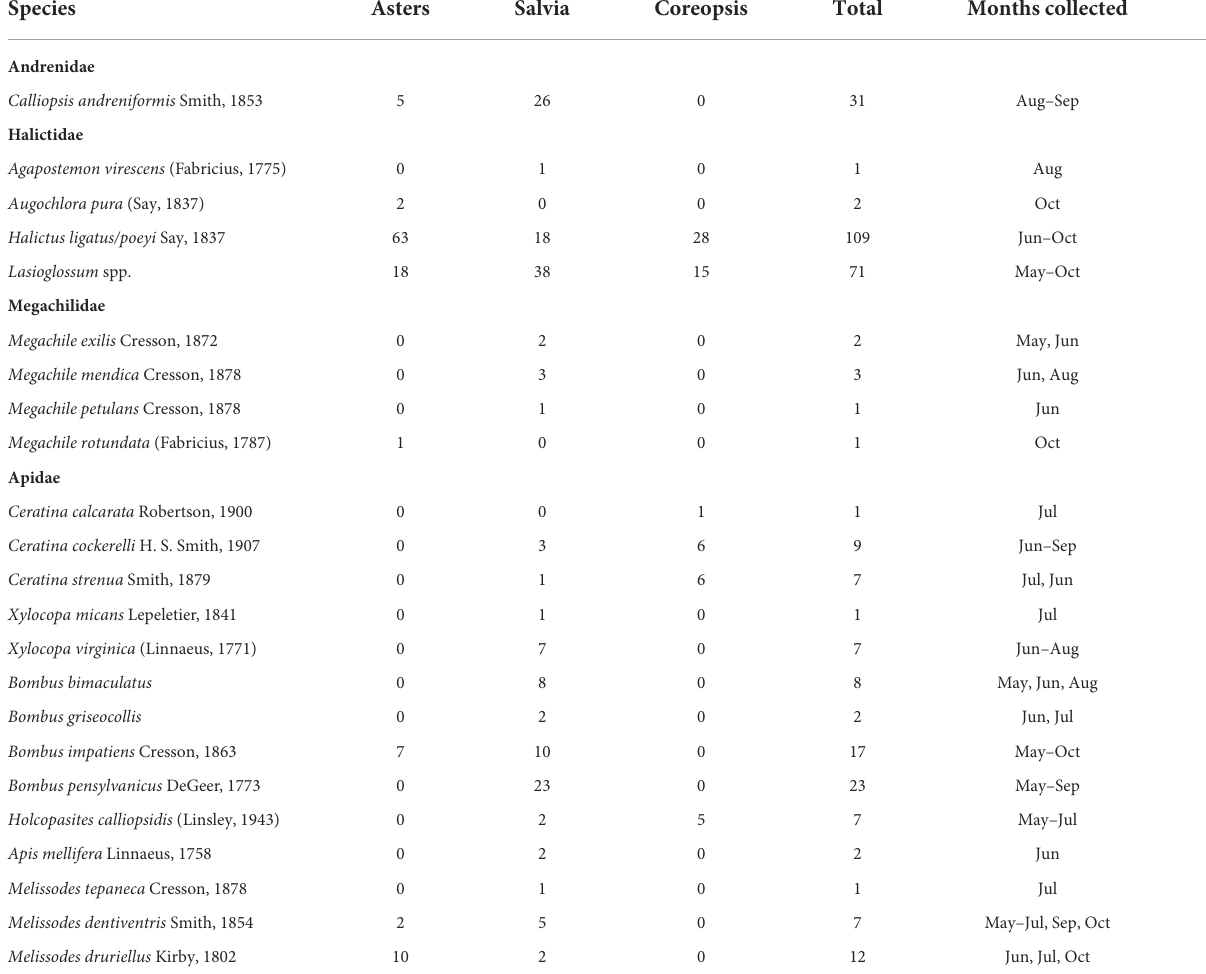
TABLE 1 Bee species collected in 2017 and 2018, from ornamental cultivar trials in the University of Georgia Research and Education Garden (Spalding Co., GA; 33 ◦ 24’67”N, 84 ◦ 26’40”W). Species